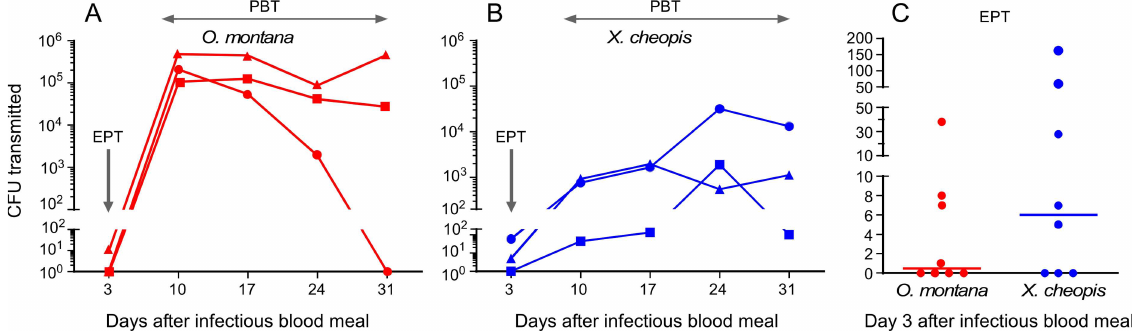
Fig 4. Transmission dynamics of O . montana and X . cheopis fleas during a four-week period after a single infectious blood meal. The numberof Y . pestis CFU transmitted by O . montana ( A ) and X . cheopis ( B ) fleas by the early-phase (EPT, day 3) and proventricularbiofilm-dependent (PBT) mechanismsin three independentexperiments. See Tables 1 and 2 for details. ( C ) Number of Y . pestis CFU transmitted in the early phase(3 days after an infectiousblood meal) by O . montana and X . cheopis in 8 independent experiments. Horizontalbars indicate the median.For these 16 EPT experiments, 103 to 202 fleas fed on day 3. The bacteremia level in the infectiousblood meals rangedfrom 1.9 x 10 8 to 3.0 x10 9